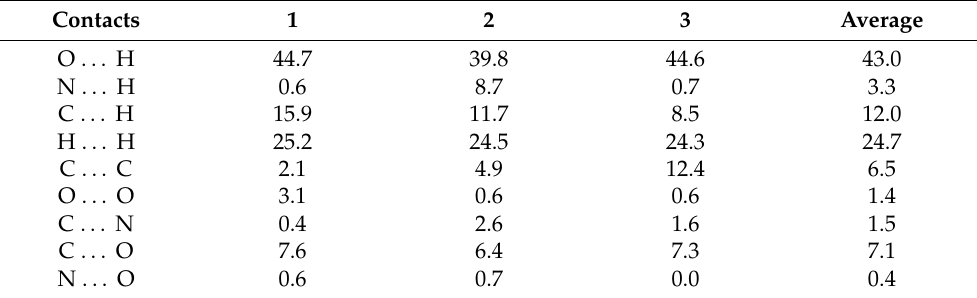
Table 2. Contributions (%) of various interactions into the Hirshfeld surface of the gallic acid molecule in the co-crystals 1 , 2 , and 3